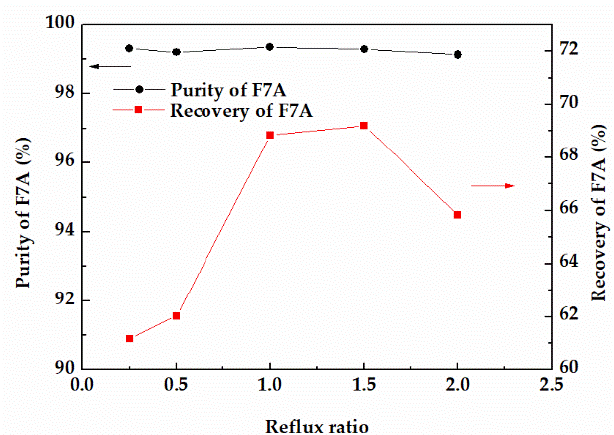
Figure 7. Effect of reflux ratio on the purity and recovery of F7A.